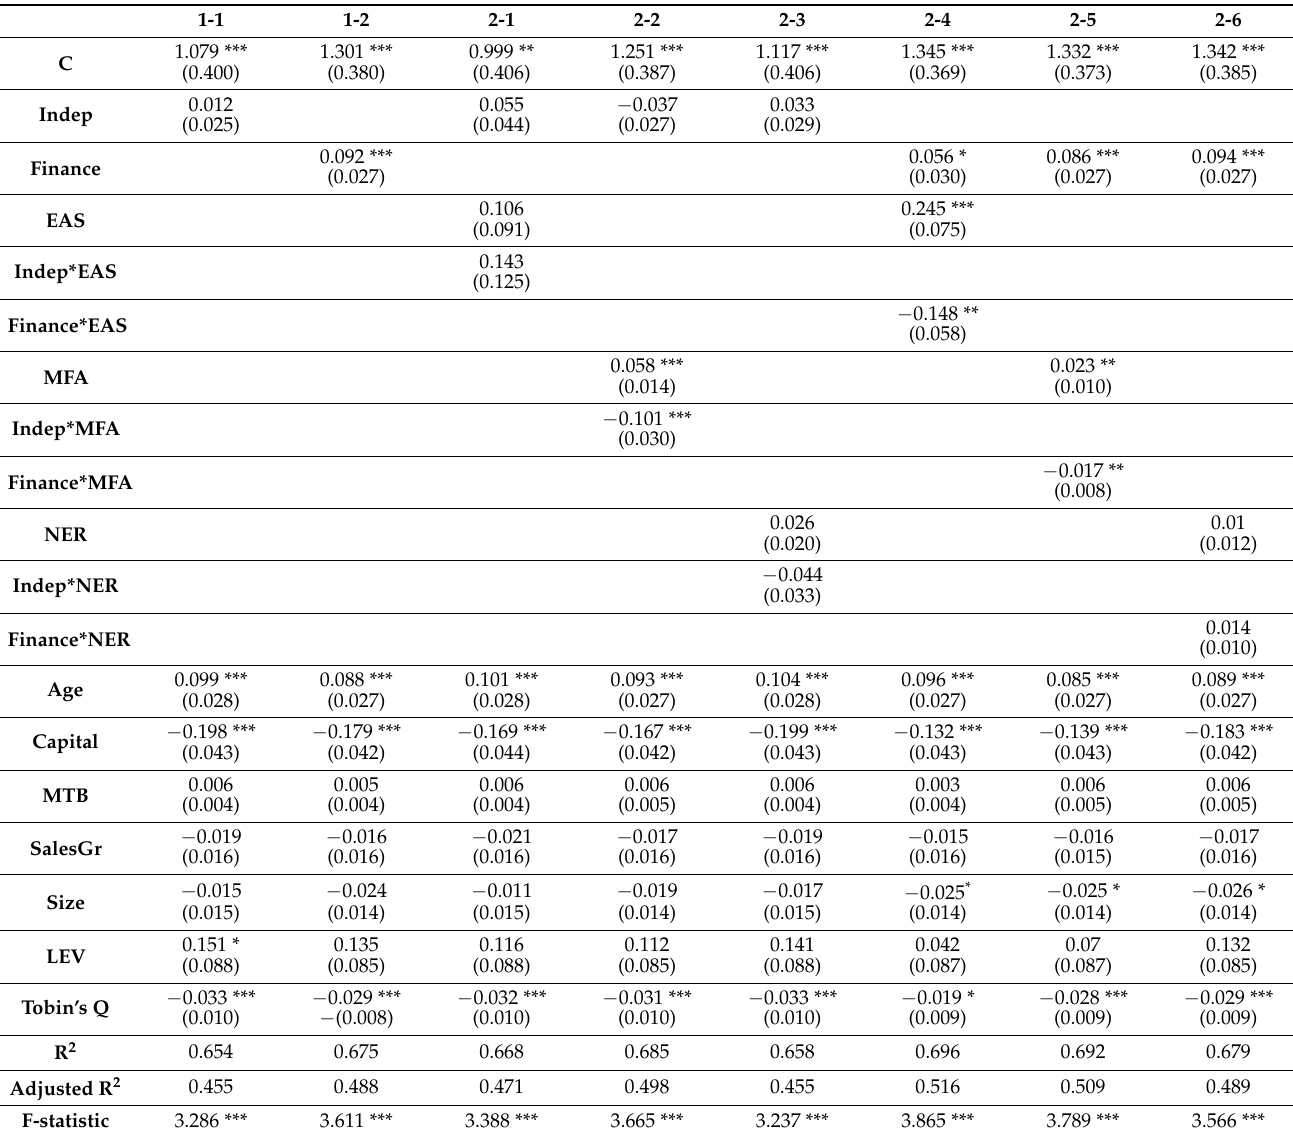
Table 6. Regression results for the low-level political